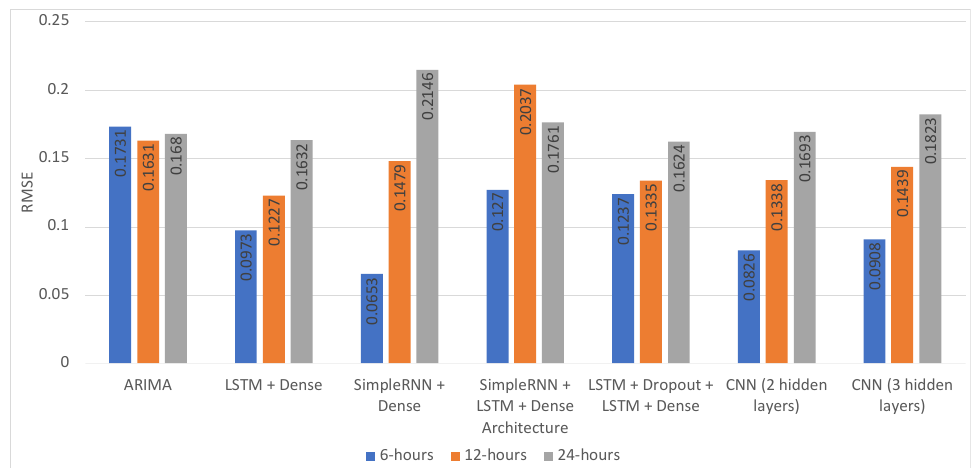
Figure 8. Performance comparison to the best models per architecture and time horizon—one month of test data.